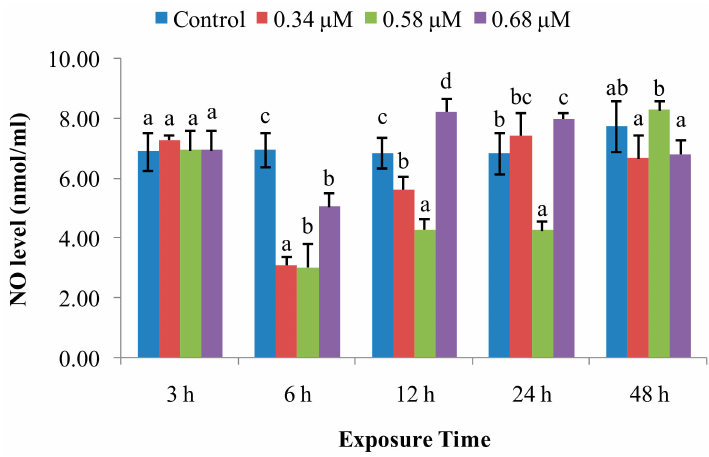
Figure 4. E ff ect of TD 49 on nitric oxide (NO) levels at di ff erent time points after exposure to di ff erent concentrations (0, 0.34, 0.58, 0.68 µ M) of TD 49 . Data represent mean ± SD values ( n = 3) at the same time interval, with di ff erent letters denoting significant di ff erences ( p < 0.05). Total protein levels (Figure 5) were increased ( p < 0.05) by all three concentrations of TD 49 tested over the untreated control group.